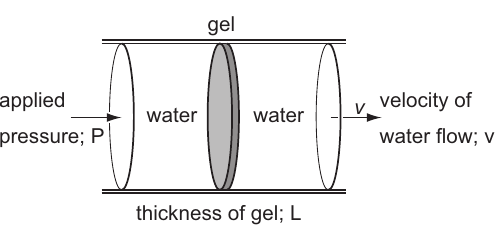
Figure 4. The schematic illustration of the principle of friction measurement. The gel of the thickness L is set in a column with the limb fixed. Then, small pressure, P , is applied to water, which covers the left side of the gel. The velocity, v , of water flowing out of gel is measured in the stationary state. The friction coefficient of gel is defined as f = P / vL .